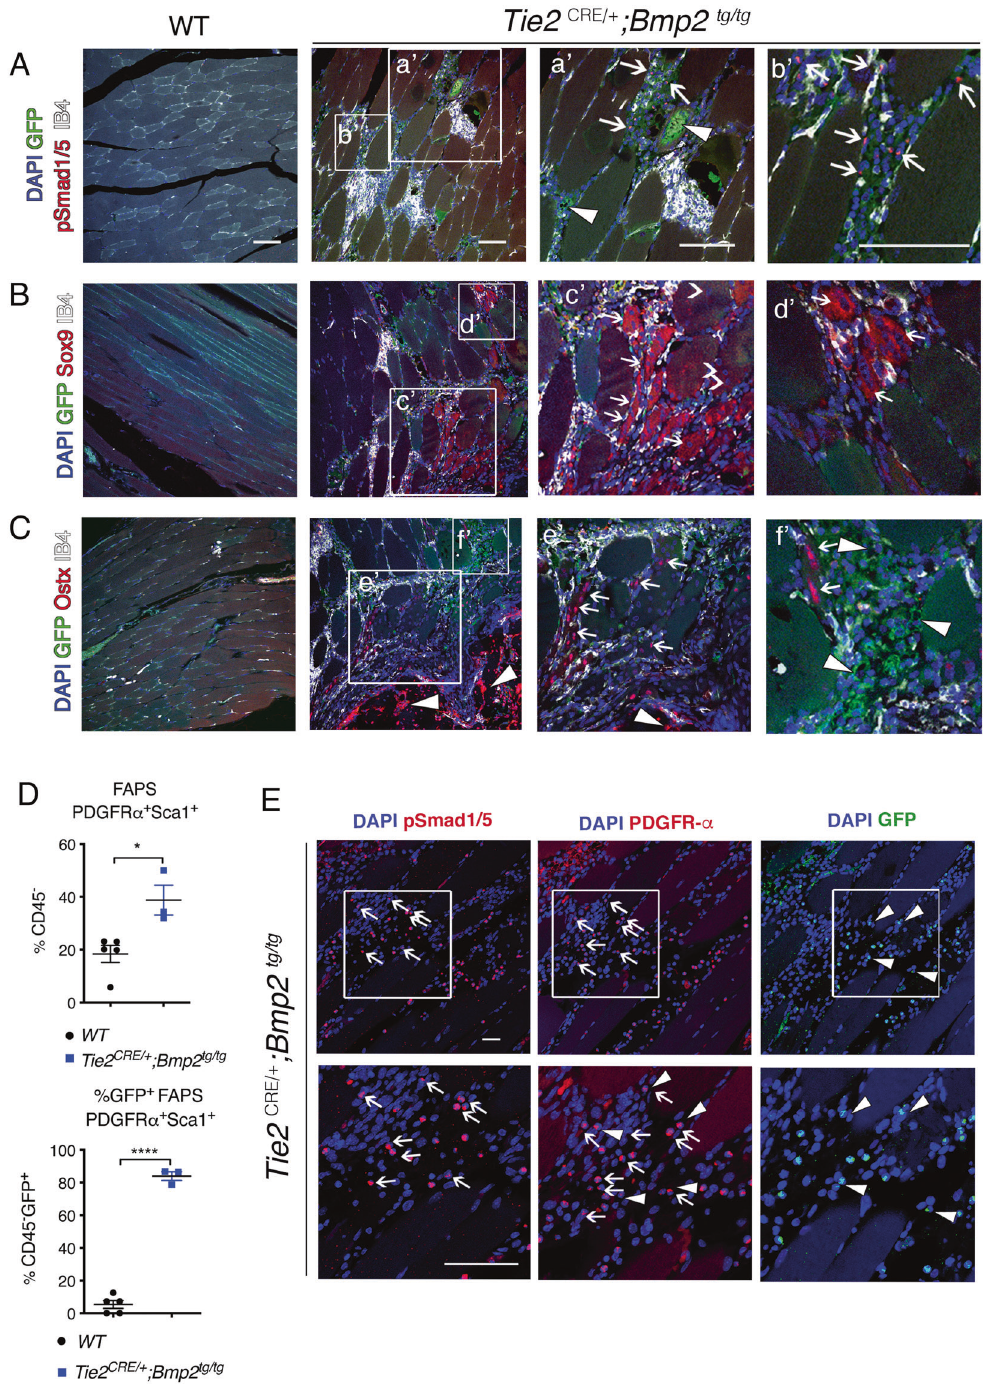
Fig. 5 Tie2 Cre/ + ;Bmp2 tg/tg resident skeletal muscle cells are characterized by pSmad1/5 and chondro-osteogenic marker expression, and increased fi bro-adipogenic progenitors. Immunodetection of indicated osteo-chondrogenic marker proteins (red), with GFP (green), IB4 (white) and DAPI (blue), on consecutive WT or Tie2 CRE/ + ;Bmp2 tg/tg hindlimb skeletal muscle sections, A Nuclear immunostaining of GFP + pSmad 1/5 (arrows) interspersed in muscle interstitium ( a ’ and b ’ ) . White arrowheads indicate GFP + adipocytes. B Cytoplasmic Sox9 immunostaining in cells (arrows in c ’ and d ’ ) surrounded by damaged skeletal muscle fi bers identi fi ed as central nuclei (open arrowheads in c ’ ). C . Nuclear immunostaining of Osterix (Osx) in cells surrounded by fi bers (arrows in e ’ and f ’ ). Arrowheads indicate strong Osx immunostaining in ectopic bone emerging areas. Arrowheads in f ’ indicate GFP + adipocytes. D Top, FACS quanti fi cation of the CD45 - PDGFR α + Sca1 + fi bro-adipogenic (FAP) population in Tie2 CRE/ + ;Bmp2 tg/tg skeletal muscle. Bottom, FACS quanti fi cation showing that 84% of the CD45 - GFP + cells are PDGFR α + Sca1 + cells. E Immunostainings of pSmad1/5/8 and PDGFR α (red), GFP (green), and DAPI (blue), on consecutive Tie2 CRE/ + ;Bmp2 tg/tg hindlimb skeletal muscle sections showing expression in connective tissue surrounding muscle fi bers. Bottom panels are magni fi cations of areas indicated in top panels. Arrows indicate co-localization of pSmad1/5 and PDGFR α cells. Arrowheads indicate co-localization of PDGFR α and GFP + cells. Cells expressing the three markers are indicated by arrows and arrowheads (middle bottom panel). Scale bars 200 µm. Unpaired t test, two tails, mean ± SD * P < 0.05; **** P <